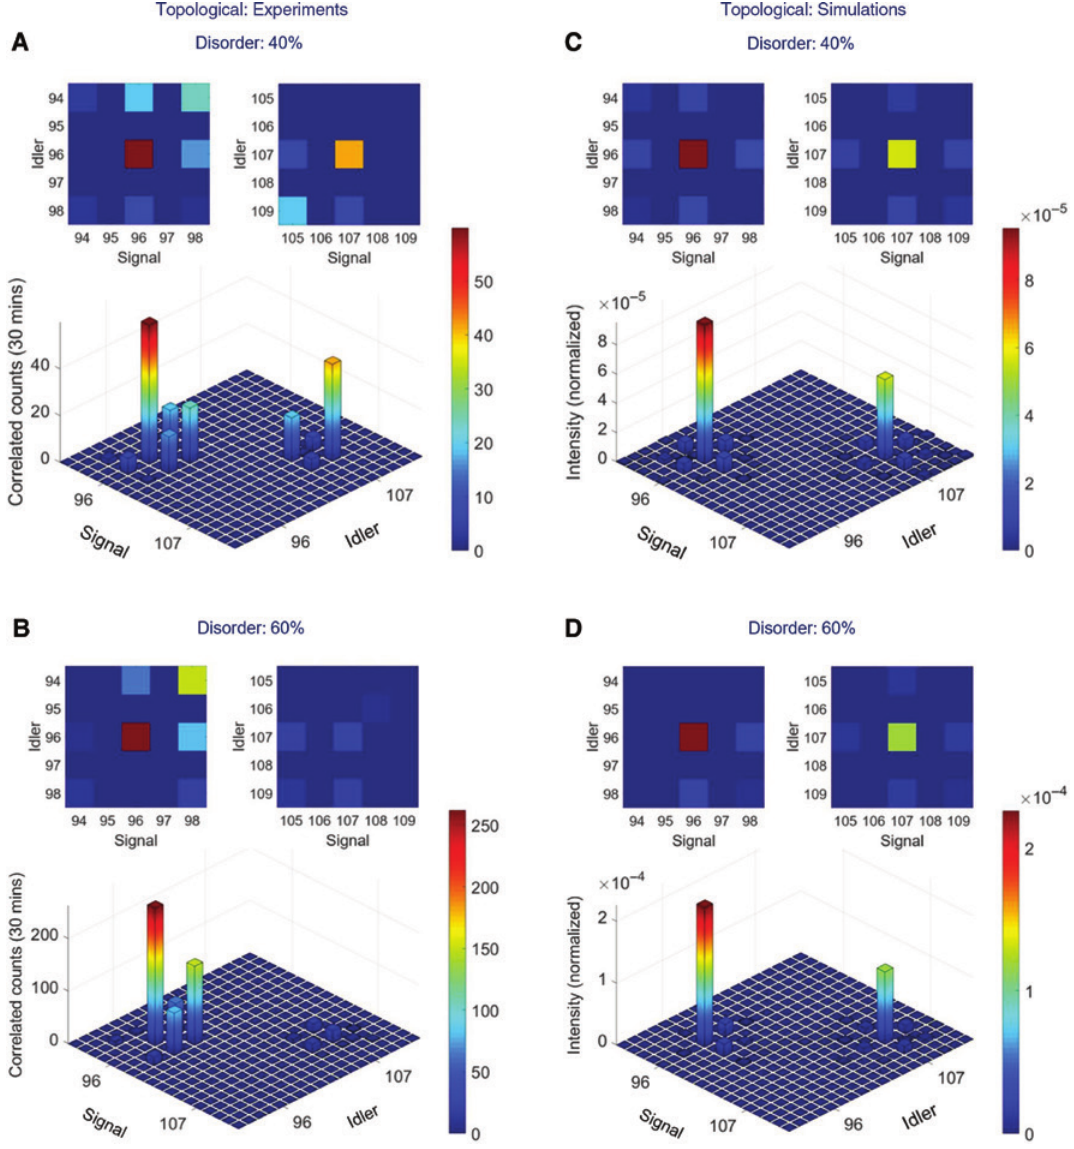
Figure 2: Biphoton states of two topological